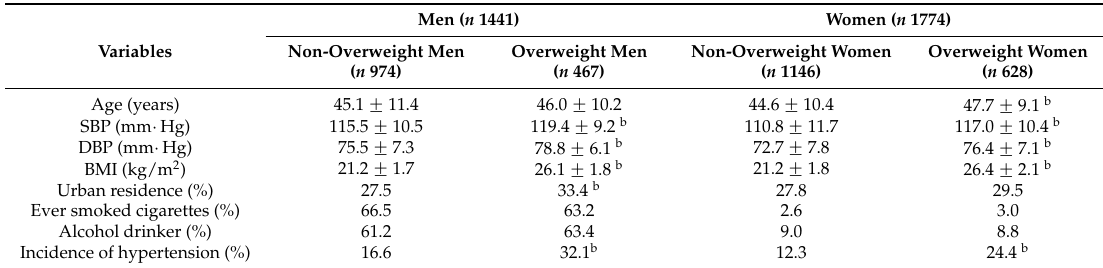
Table 1. Baseline characteristics of 3215 study participants a .